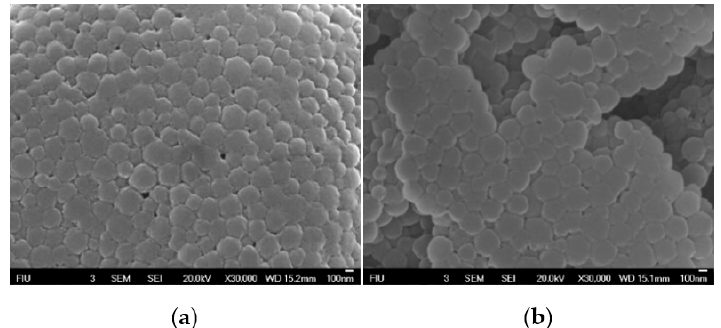
Figure 6. Scanning electron micrographs of Cyt c-PLGA-PEG NPs. ( a ) NP-253 and ( b ) NP-354. Scale bar in a and b:100 nm.